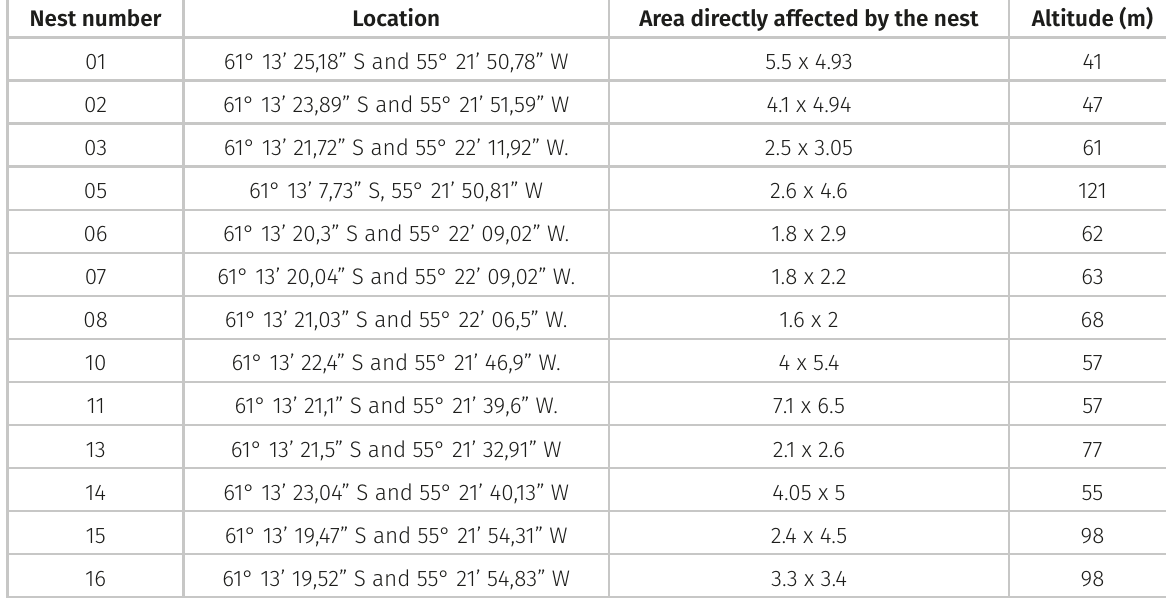
Table I. Geographical location, area directly affected and altitude of the nest studied. Nest